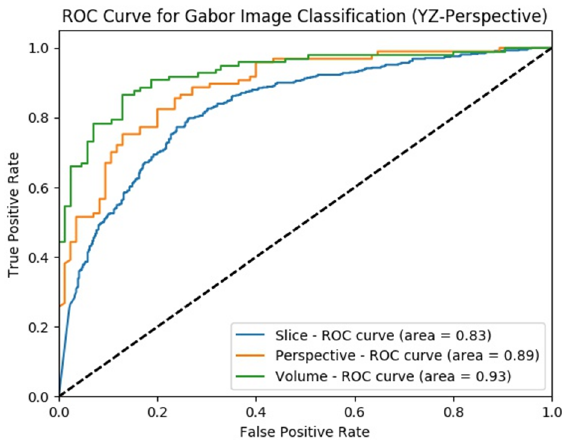
Figure 17. SFMPF model using Bilateral image—change in classification performance for slice, perspective, and volume-level classifications for each perspective.